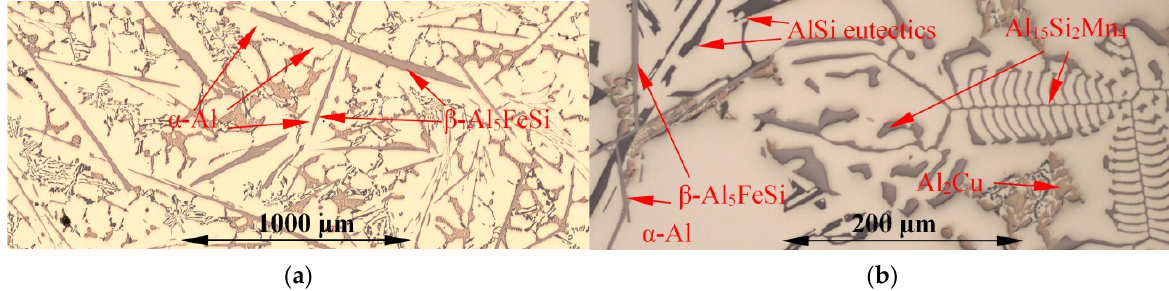
Figure 10. Microstructures of: ( a ) the AlCu4Si6Fe2.0 specimen solidified with electromagnetic stirring, LOM magnification 100x and ( b ) the AlCu4Si6Fe1.0Mn0.65 specimen solidified without electromagnetic stirring, LOM magnification 500×.